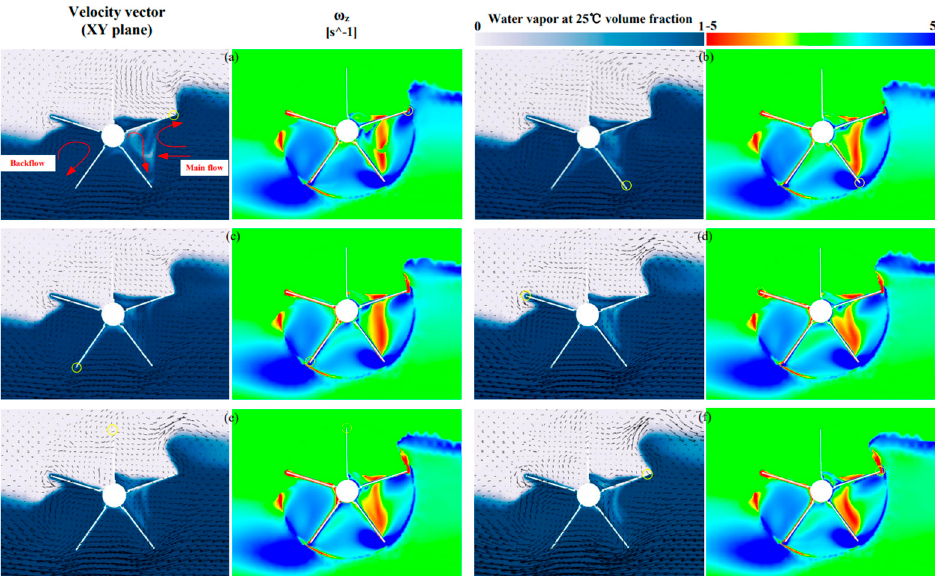
Figure 9. Contours of velocity vectors, water volume fraction, and vorticity in a cycle of the 86 mm clearance water wheel. ( a ) The circumferential angle θ = 0°; ( b ) The circumferential angle θ = 72°; ( c ) The circumferential angle θ = 144°; ( d ) The circumferential angle θ = 216°; ( e ) The circumferential angle θ = 288°; ( f ) The circumferential angle θ = 360°.